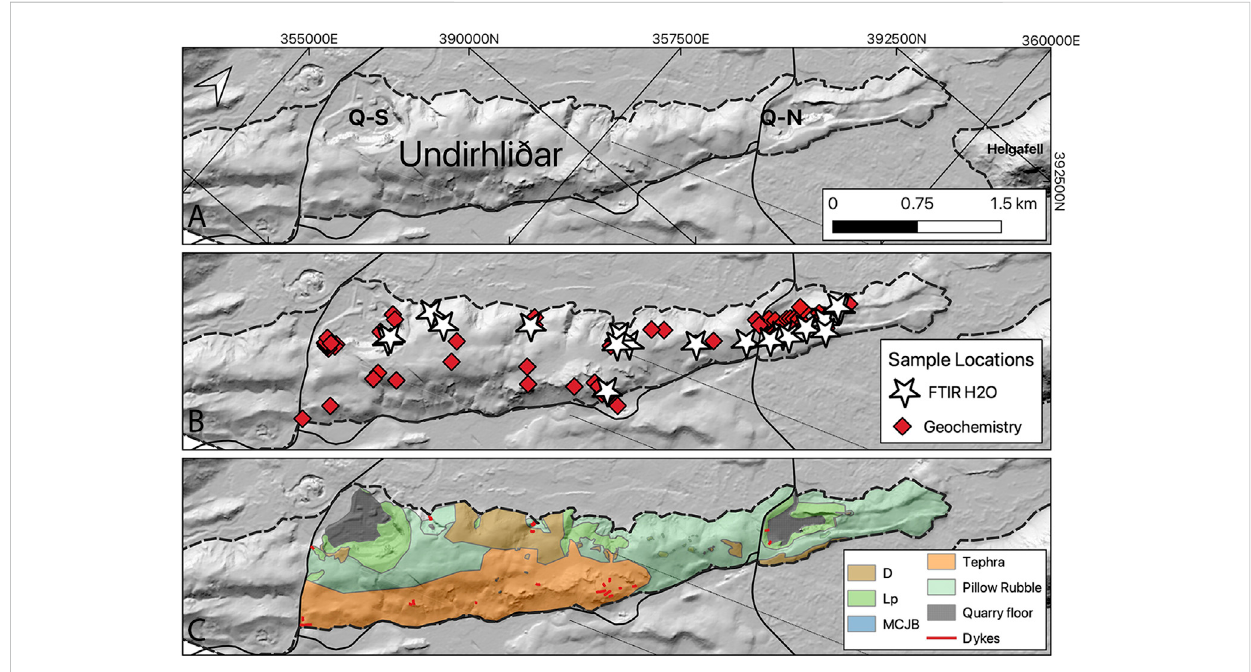
FIGURE 2 Maps showing the morphology, sample locations, and geology of Undirhliðar ridge between Undirhliðar (Q – N) and Vatnsskarð (Q – S) quarries. (A) Digital elevation model (DEM) showing the overall ridge morphology; data for the DEM from the ArcticDEM website, sampled at 1.0 m resolution. (B) Locations of samples used in this study. (C) Geology of the ridge based on new mapping.